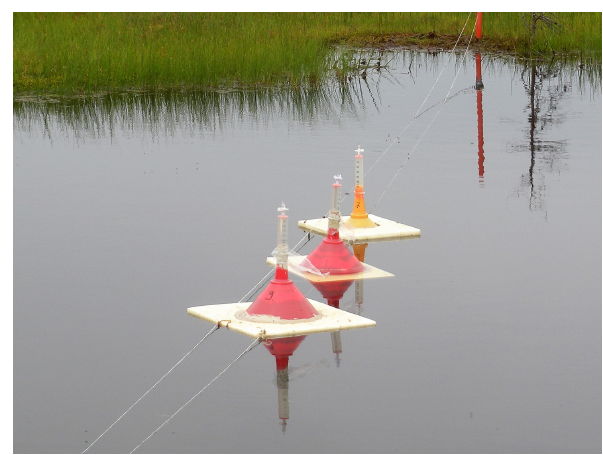
Figure 1. Floating gas traps in an open water peatland pool (OW).